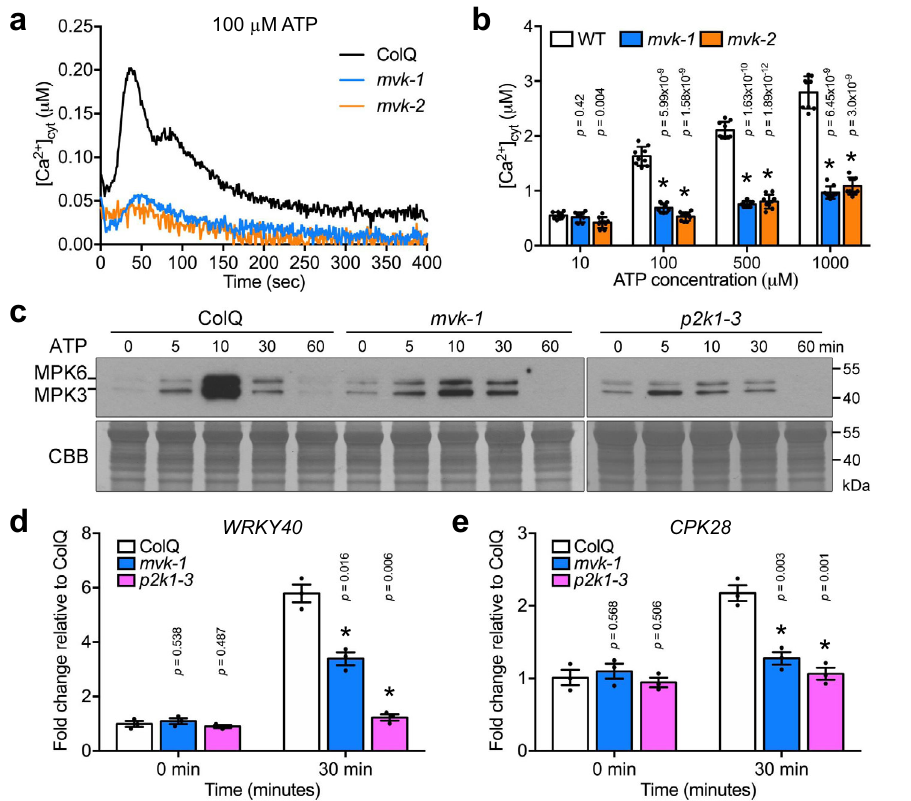
Fig. 1 mvk-1 mutants show lower response to extracellular ATP. a The kinetics of the cytoplasmic calcium response to 100 μ M ATP for 400 sec in ColQ, mvk-1 , and mvk-2 ( mvk-2-4 line) plants. b The bar graph shows the integrated calcium response to 10, 100, 500, and 1000 μ M of ATP for 400 sec in ColQ, mvk-1 , and mvk-2 ( mvk-2-4 line) mutant plants. Asterisks indicate signi fi cant differences between ColQ and mvk mutants plants (means ± SEM, n = 9 seedlings, * P < 0.001, two-sided Student ’ s t test). c The mvk-1 mutant plant exhibits reduced phosphorylation of MPK3 and MPK6 in response to 100 μ M of ATP compared to wild-type over a time-course from 0 to 60 min. Phosphorylation of MPK3 and MPK6 was detected using antibody against phospho-p44/p42 mitogen-activated protein kinase. p2k1-3 mutant plants were used as a negative control. The coomassie brilliant blue (CBB) staining (bottom panel) showed equal loading. d , e Relative expression of WKRY40 and CPK28 in 10-day-old ColQ, mvk-1 , and p2k1-3 whole seedlings treated with 100 μ M ATP for 30 min was performed using qRT-PCR analysis. Gene expression data were normalized using the SAND reference gene. Bar graphs represent means of three pooled biological replicates. Asterisks indicate the signi fi cant differences compared to ColQ at the same time points (* P < 0.05, two-sided Student ’ s t test). All above experiments were repeated three times with similar